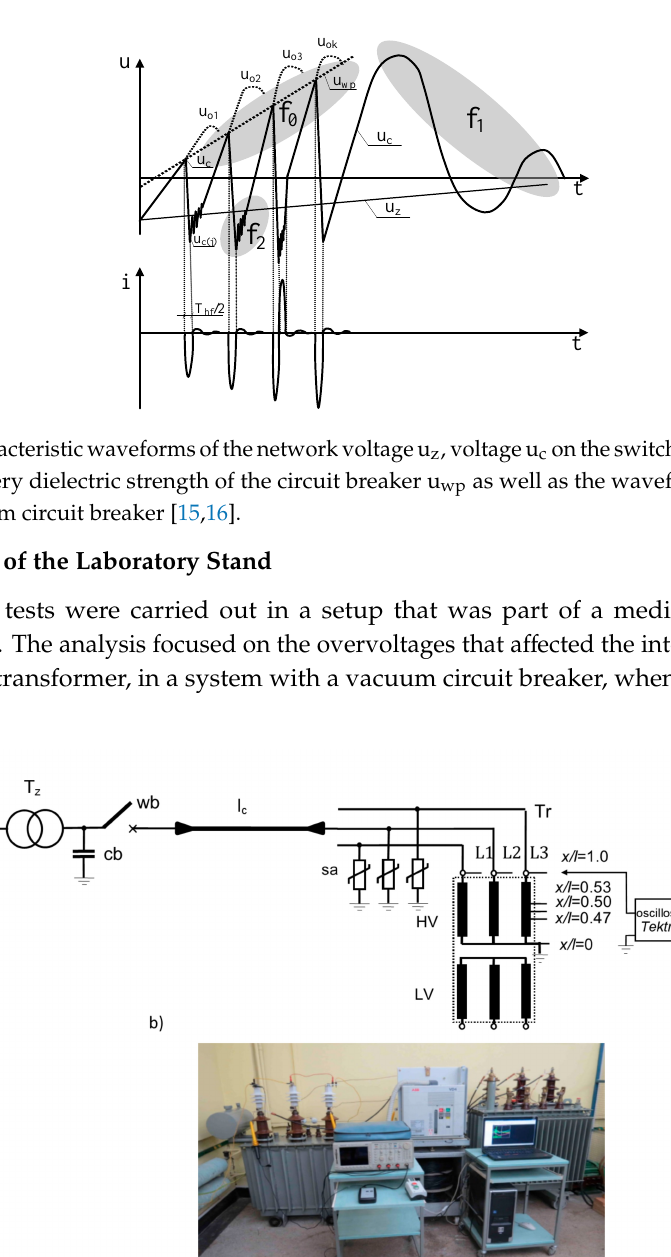
Figure 3. System for testing overvoltages when switching off the transformer with a vacuum circuit breaker: ( a ) — test system diagram; ( b ) — stand view: wb — vacuum switch, Tz — power transformer,